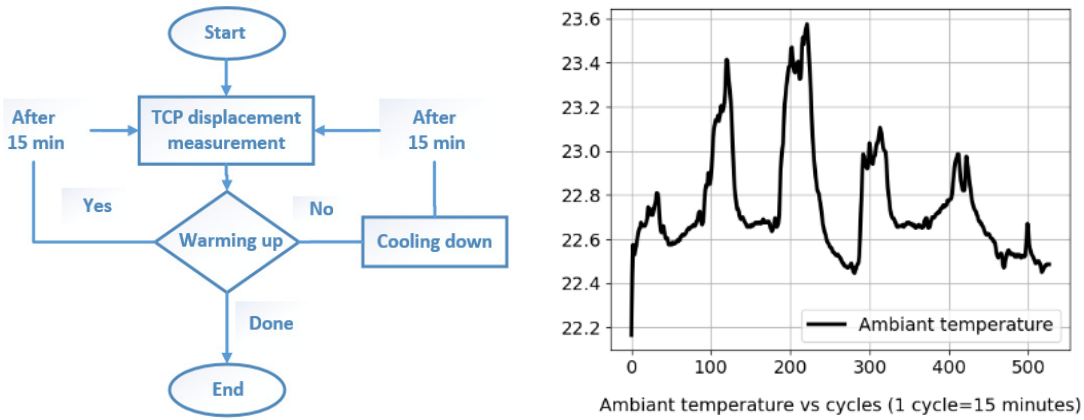
Figure 2. Heating and cooling processes and ambient temperature .